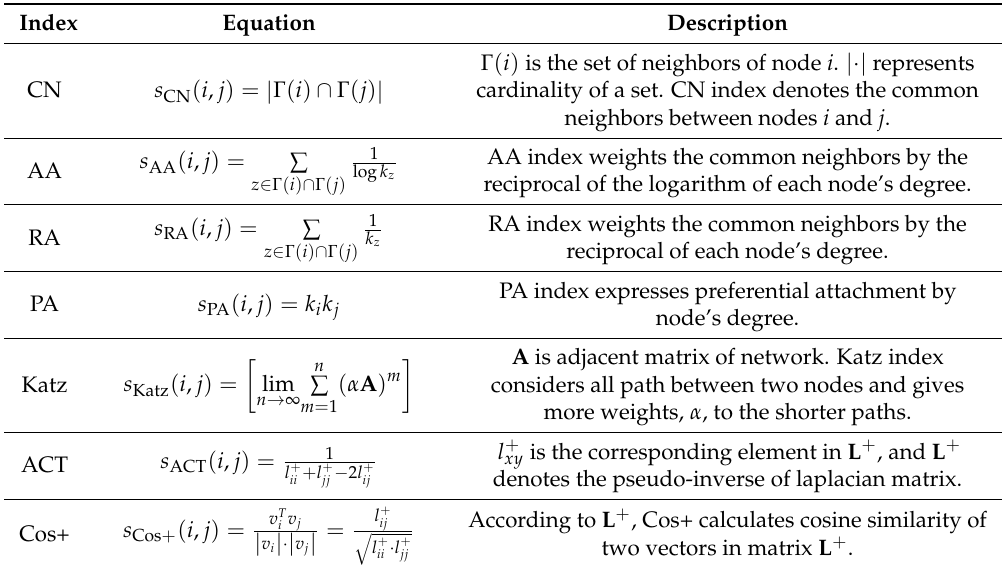
Table 4. Definitions and descriptions of similarity indices.